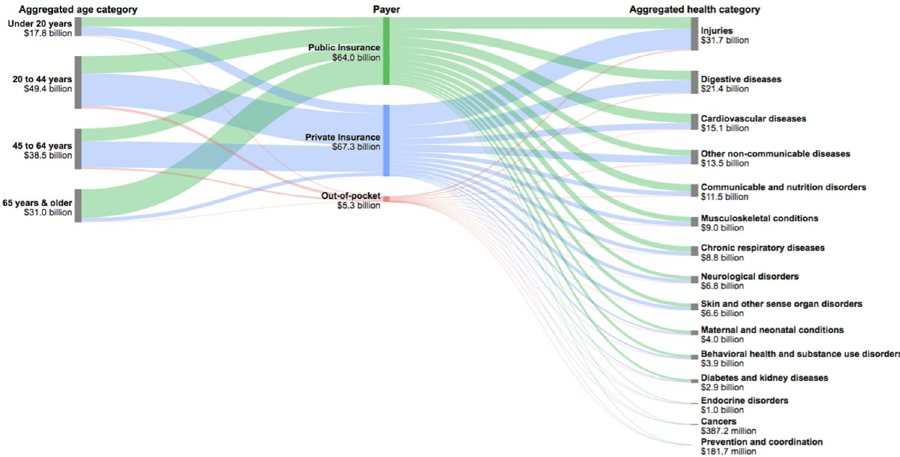
Fig 2. Emergency department spending across aggregated age groups, payer, and aggregated health categories, 2016 ($ billions).